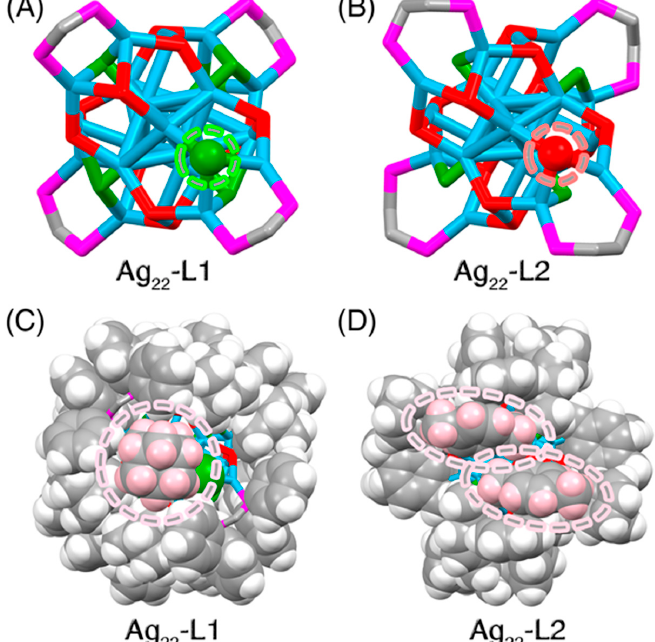
Figure 2. Structure comparison between Ag 22 -L1 and Ag 22 -L2 nanoclusters. ( A ) Cluster framework of the Ag 22 -L1 nanocluster with Cl ligands at specified locations. ( B ) Cluster framework of the Ag 22 -L2 nanocluster with SR ligands at specified locations. ( C ) Spacefill packing of the Ag 22 -L1 nanocluster with a S-Adm ligand at the specified surface vacancy. ( D ) Spacefill packing of the Ag 22 -L2 nanocluster with two S-PhMe 2 ligands at the specified surface vacancy. Color codes: light blue sphere, Ag; red sphere, S; magenta sphere, P; green sphere, Cl; grey sphere, C; pink/white sphere,